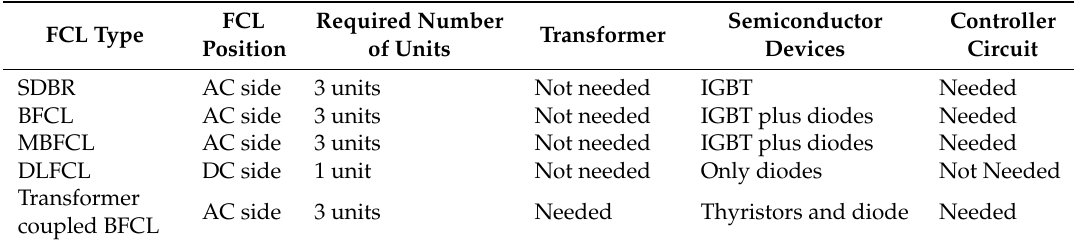
Table 3. Non-superconducting fault current limiter summary.